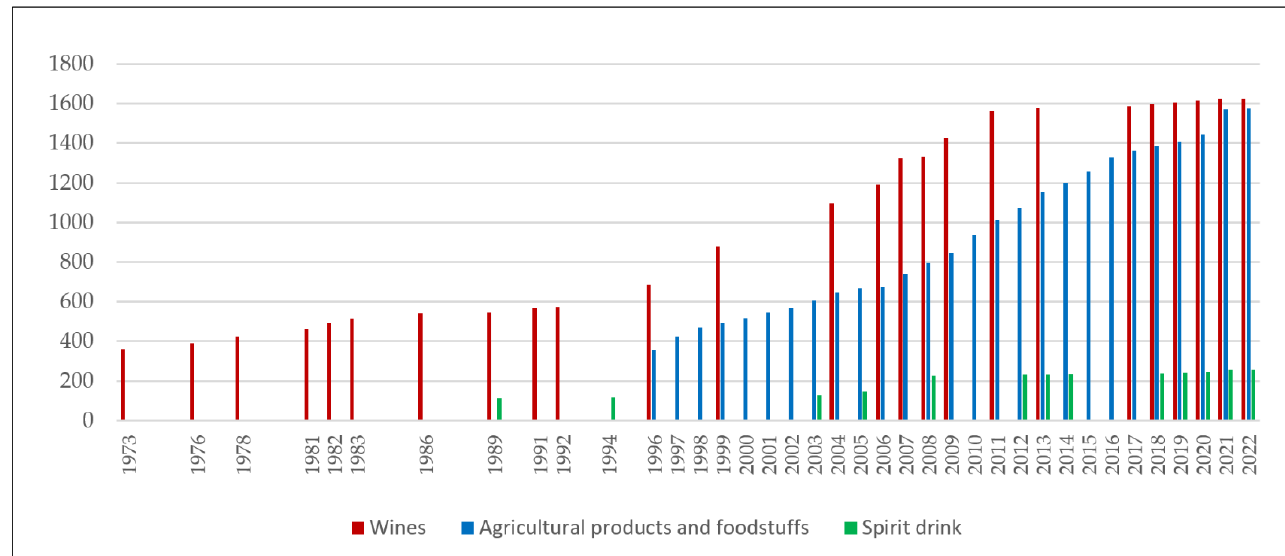
Figure 3. Evolution of the number of products registered in Europe as protected geographical indications. Source: Data from the European Commission. eAmbrosia, EU Register of Geographical Indications (last consulted in February 2022). Own elaboration.